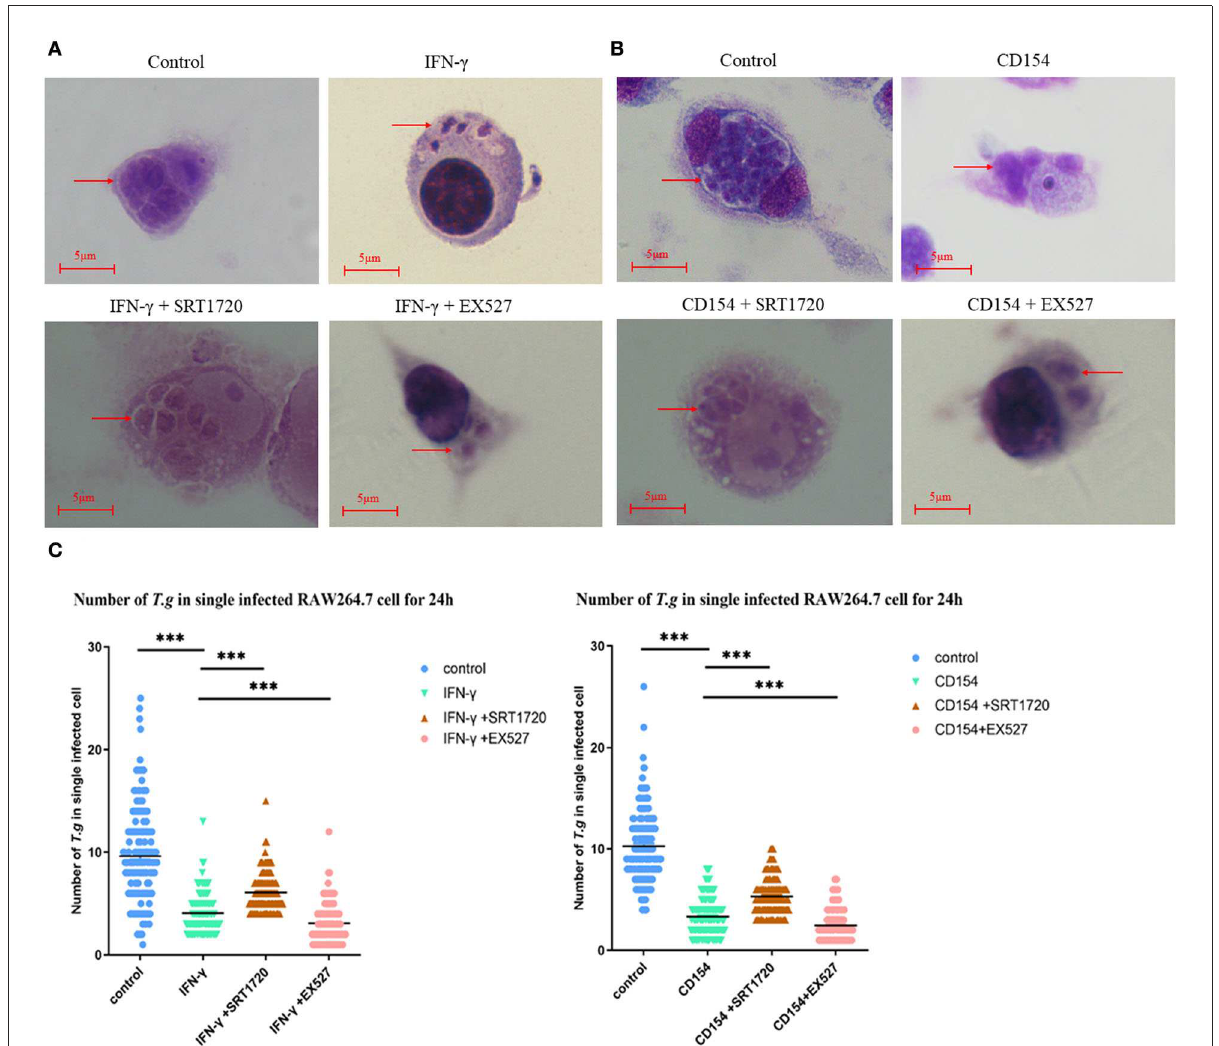
FIGURE4 Intracellular growth of RH tachyzoites inside mouse macrophages with regulation by Sirtuin 1 (SIRT1) and interferon gamma (IFN- γ ) or CD154 at different time points. RAW 264.7 macrophages were either infected with RH tachyzoites at a ratio of 5:1 (parasite/host cell) for 2h or left in the culture plate without infection, followed by incubation with IFN- γ (1 µ g/ml), CD154 (200ng/ml), IFN- γ (1 µ g/ml) and SRT1720 (5 µ M), IFN- γ (1 µ g/ml) and EX527 (10 µ M), CD154 (200ng/ml) and SRT1720 (5 µ M), or CD154 (200ng/ml) and EX527 (10 µ M) for 24h. Before observation under light microscopy. (A) Observation under light microscopy pointed out that the infected macrophages had much heavier intracellular tachyzoite burdens than infected macrophages incubated with IFN- γ at 24h after infection. SRT1720 neutralized the intracellular tachyzoites’ downward trend caused by IFN- γ , while EX527 enhanced the downtrend. (B) Observation under a light microscope revealed that the infected macrophages had much heavier intracellular tachyzoite burdens than infected macrophages incubated with CD154 at 24h after infection. SRT1720 neutralized the intracellular tachyzoites’ downward trend caused by IFN- γ , while EX527 enhanced the downtrend. (C) A scattered distribution chart showing the means of the intracellular tachyzoite counts. Values represent actual numbers (scattered dots) and means (black line) from three independent experiments; in each case, at least 200 infected cells were counted. *** P <